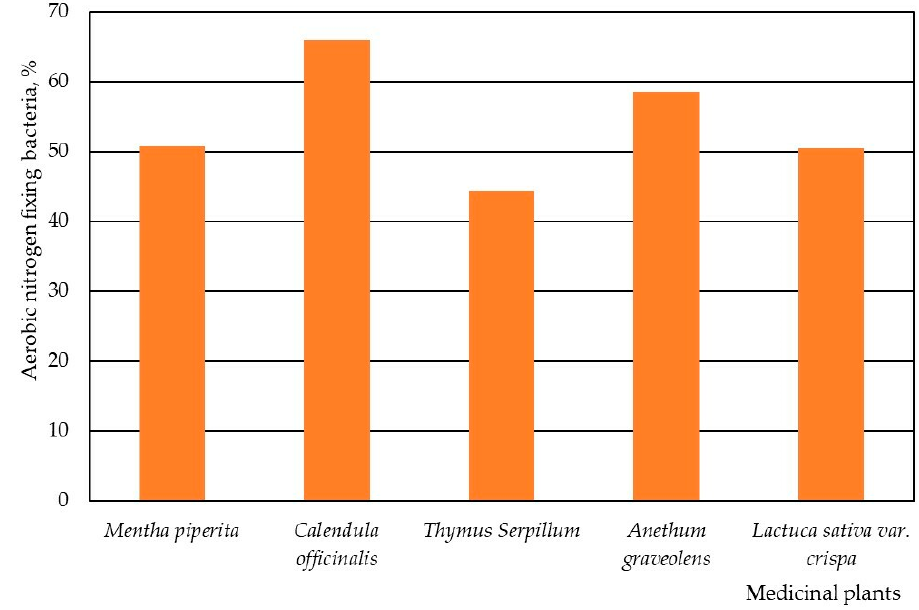
Figure 8. Aerobic nitrogen-fixing bacteria (%) soils of agroecosystems with medicinal plants without antibiotics. The data are statistically significant, p < 0.05, x ± SD, n = 4.